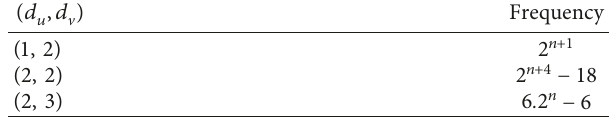
Table 2: Degree-based edge partition of PETIM, of end vertices of each edge.